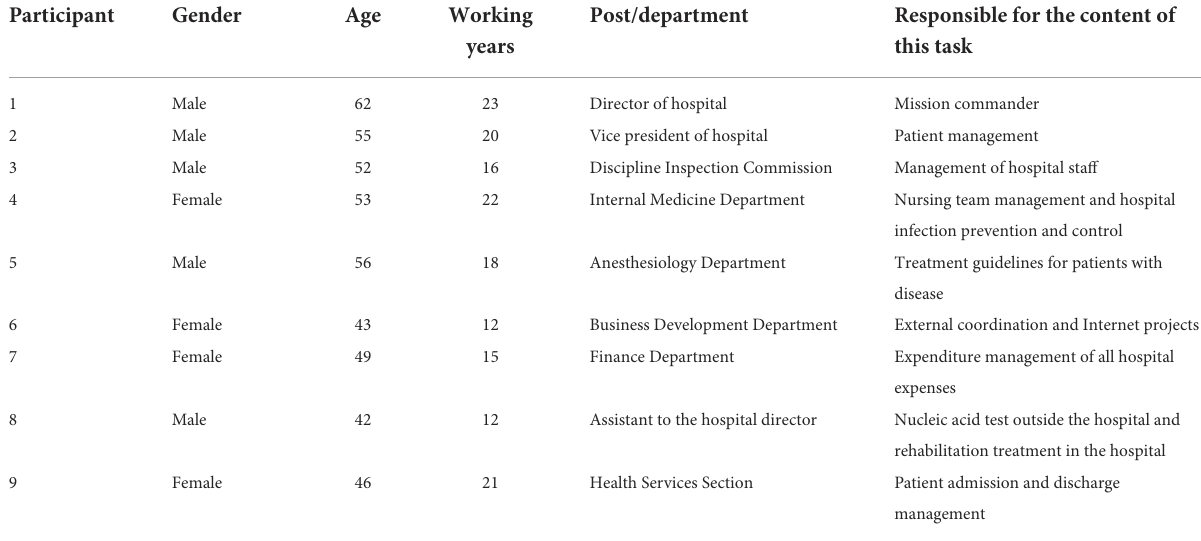
TABLE 1 Demographic characteristics of participants and data related to rehabilitation